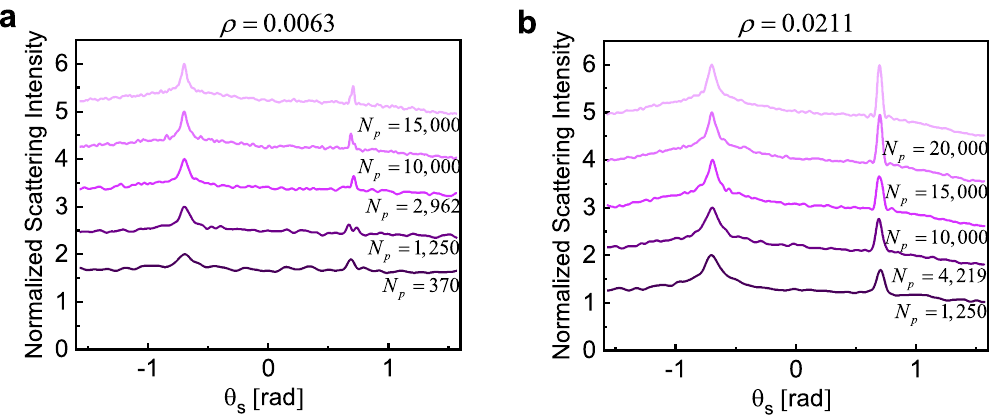
Figure 7. Normalized ensemble-averaged scattering intensity for two different density factors ρ while the number of particles and the size of the enclosing box are changed. Curves correspond to ( a ) ρ = 0.0063 , L = ( 10, 15, 20, 30, 34.3 ) (cid:31) 0 , and ( b ) ρ = 0.021 , L = ( 10, 15, 20, 22.9, 25.2 ) (cid:31) 0 with darker colors corresponding to smaller boxes and smaller number of particles. Ensemble averaging is performed over N r = 5, 000 realizations and the angle of incidence is fixed at θ i = 40 (deg) . In all cases the maximum value is normalized to two and for clarity, each curved is moved one unit up compared to the previous